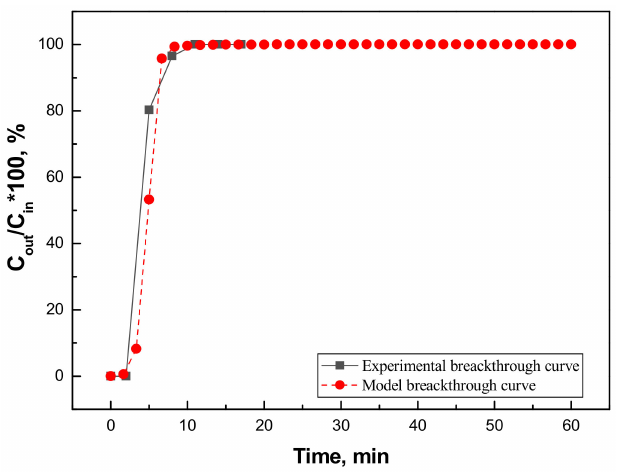
Figure 6. Experimental and model breakthrough curves of CO 2 adsorption onto CFAZ.